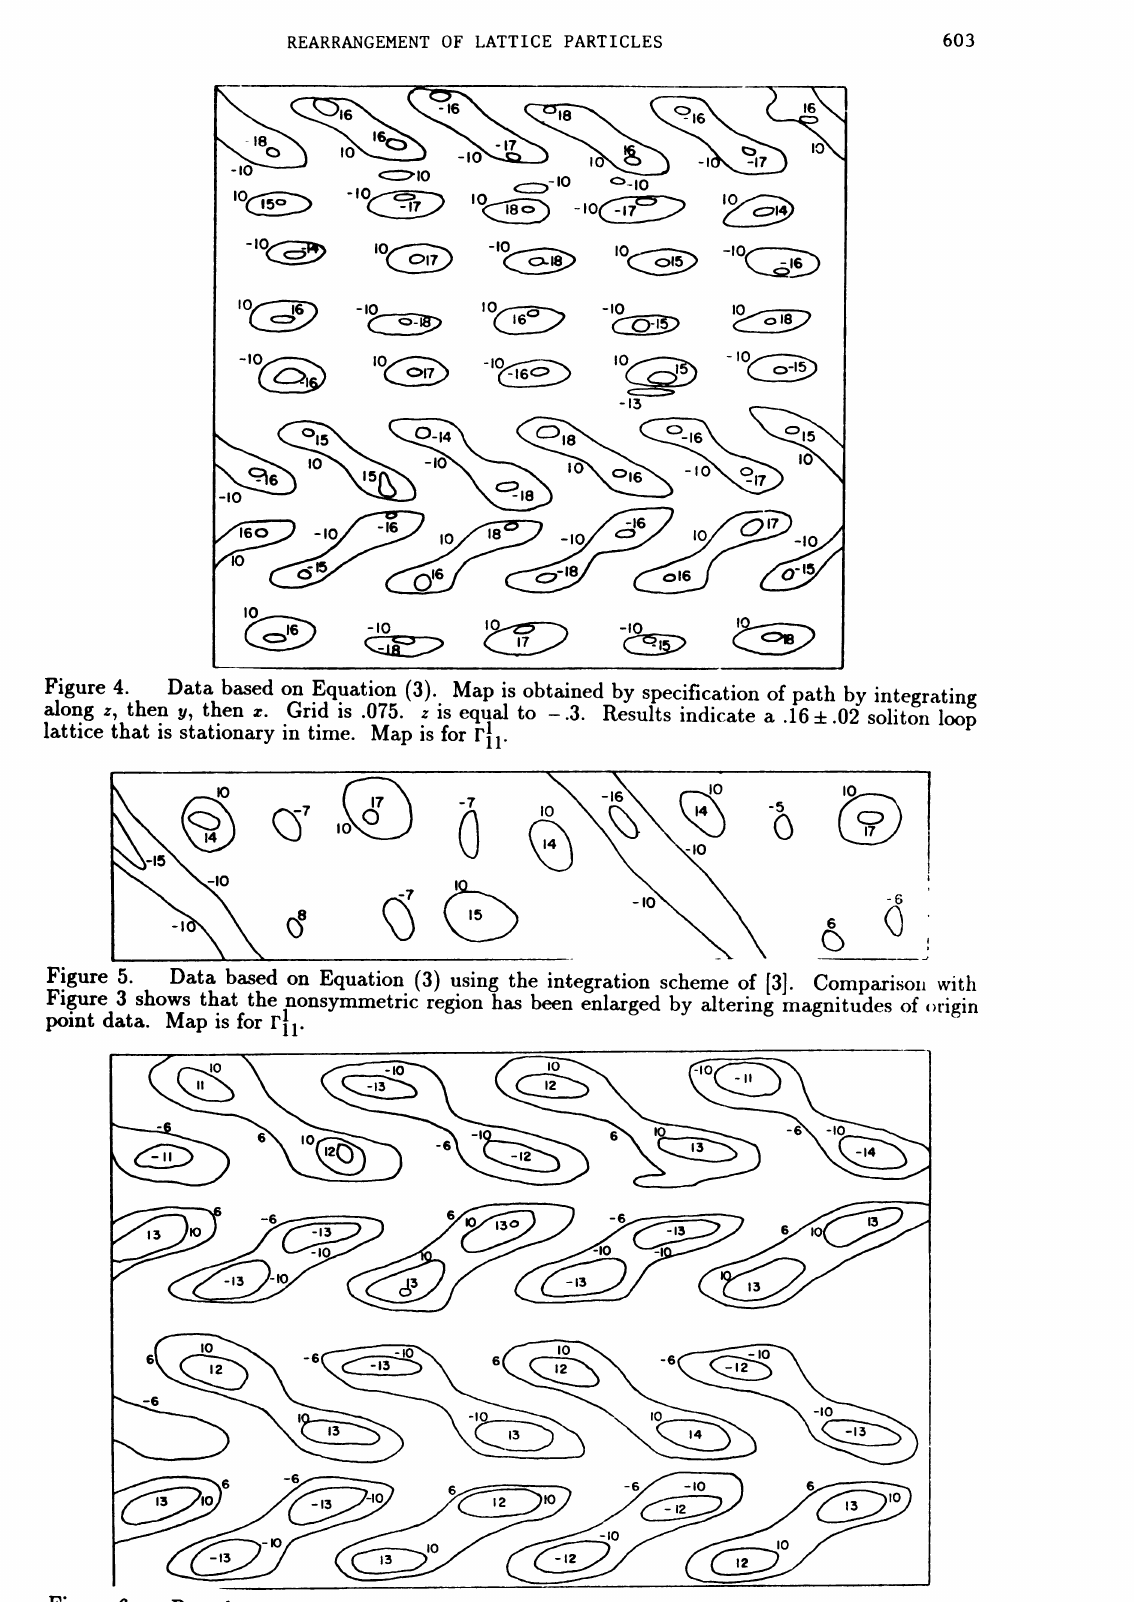
Figure 6. Data based on Equation (5). Map z has value of -.6 the data is consistent with .12 4-.01. Map is for